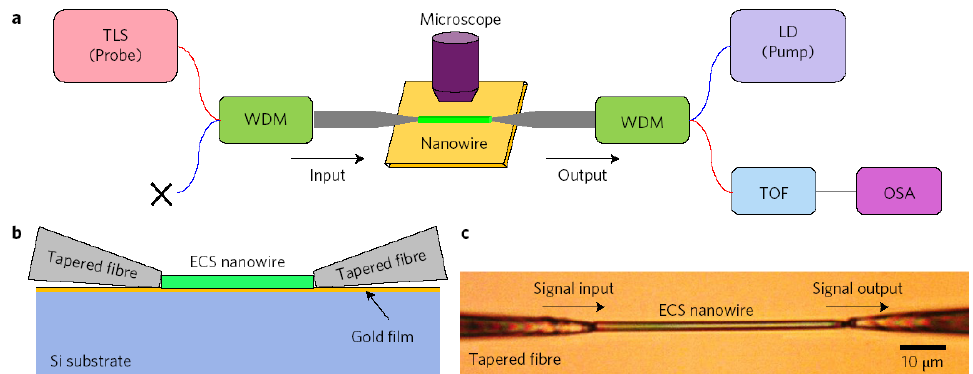
Figure 3. Experimental layout of the signal enhancement measurement. ( a ) Schematic of the pump- probe measurement. ( b ) Side view of the coupling configuration. The tapered fibers are placed in direct contact with the two end-facets of the nanowire at a small angle. ( c ) Top-view microscope image of the coupling system [39].